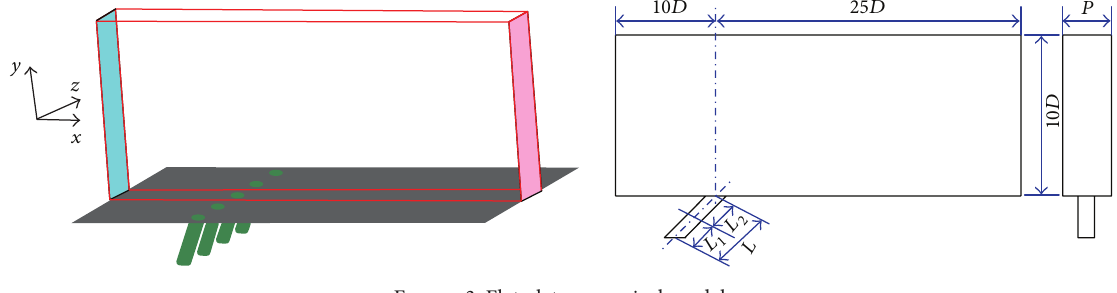
Figure 3: Flat plate numerical model.